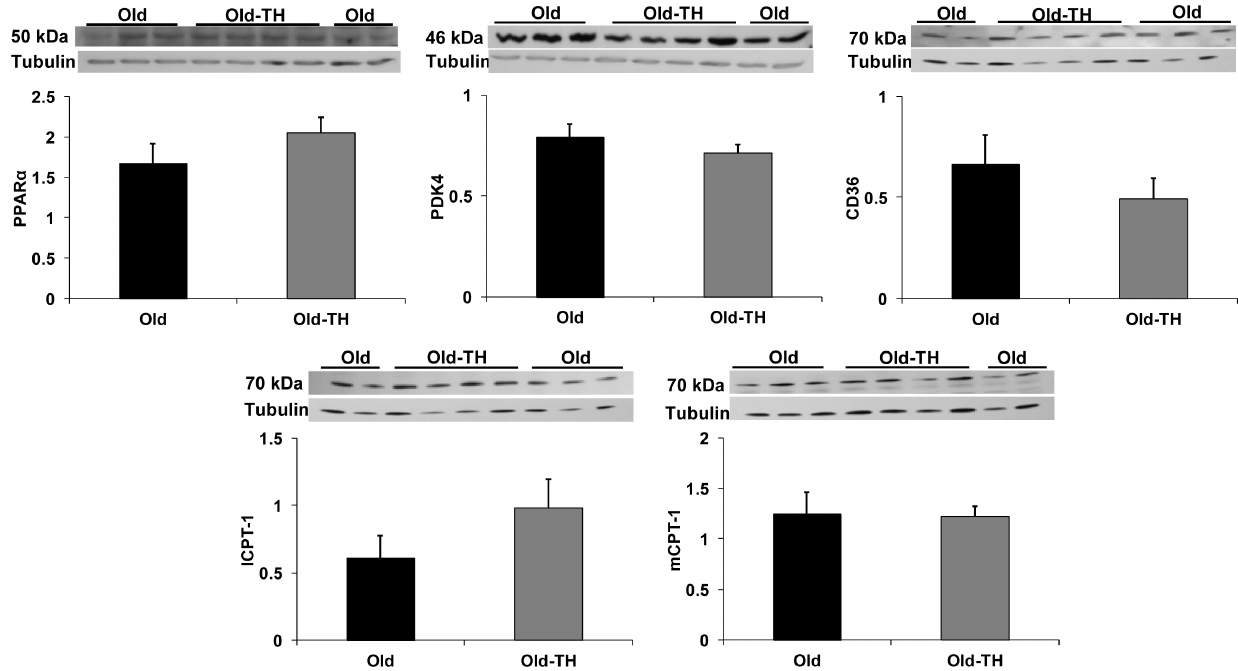
Figure 2. Expression of proteins involved in the regulation of fatty acid metabolism . All values are arbitrary units normalized to a -tubulin (tubulin) as shown in the figure. The approximate molecular weight of each protein is noted. n=4–5 per group. No differences were found between the groups for any protein. PPAR, peroxisome proliferator-activated receptor; PDK, pyruvate dehydrogenase kinase; lCPT-I, liver-specific carnitine palmitoyltransferase 1; mCPT-1, muscle-specific CPT-1. Note that CD36 and lCPT-1 were run on the same membrane after antibody stripping.